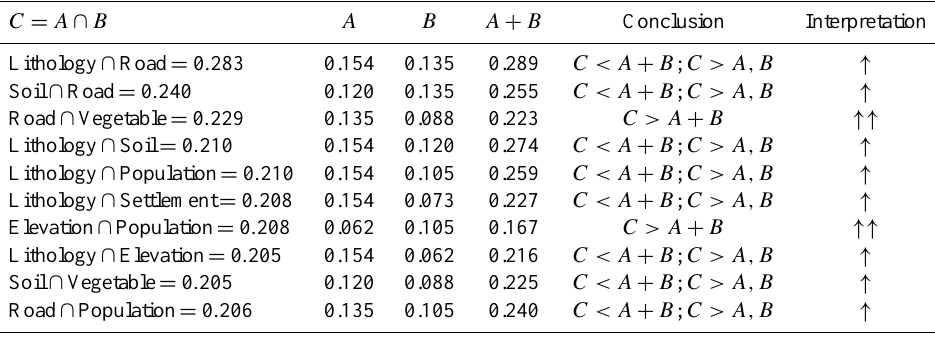
Table 5. Interaction between pairs of driving factors influencing the KRD improvement. C = A ∩ B A B A + B Conclusion Interpretation Lithology ∩ Road = 0 . 283 Soil ∩ Road = 0 . 240 Road ∩ Vegetable = 0 . 229